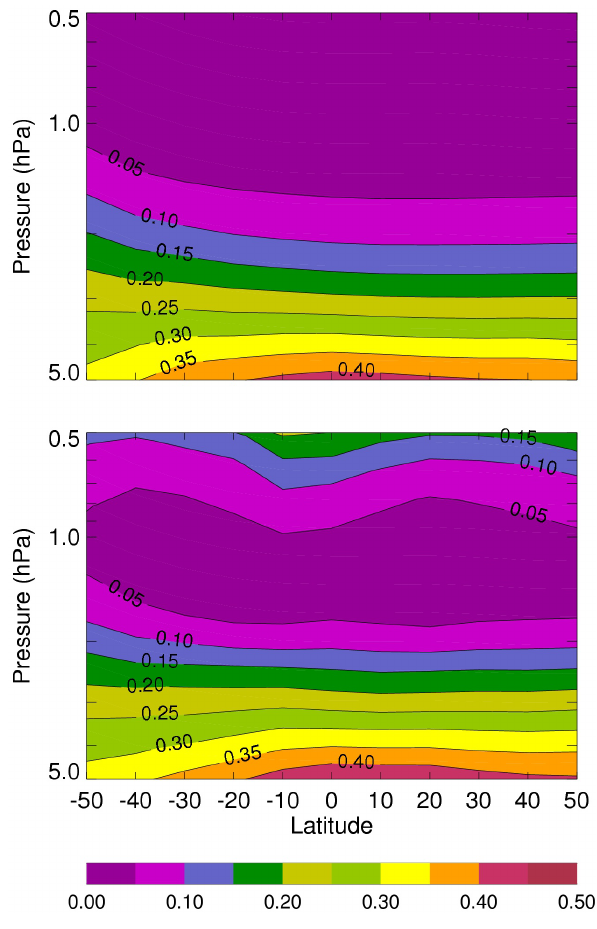
Fig. 10. Ascending/descending (or day/night) NO 2 ratio (top) from the diurnal model and (bottom) from the LIMS V6 data. Orange- to-red colors are high ratios, while magenta colors are low ratios.